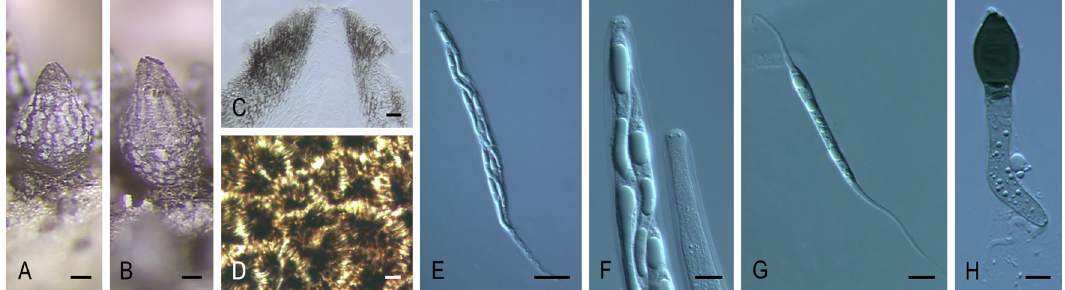
Figure 10. Triangularia striata SMH 3431. ( A , B ) Ascomata. ( C ) Neck. Triangularia striata SMH 4036. ( D ) Ascomal wall. ( E ) Ascus. ( F ) Ascus apex. ( G , H ) Ascospores. Bars: ( A , B ) = 100 µm; ( C , D , F – H ) = 10 µm; ( E ) = 50 µm. Pictures ( A – D , F , G ) adapted from [48].